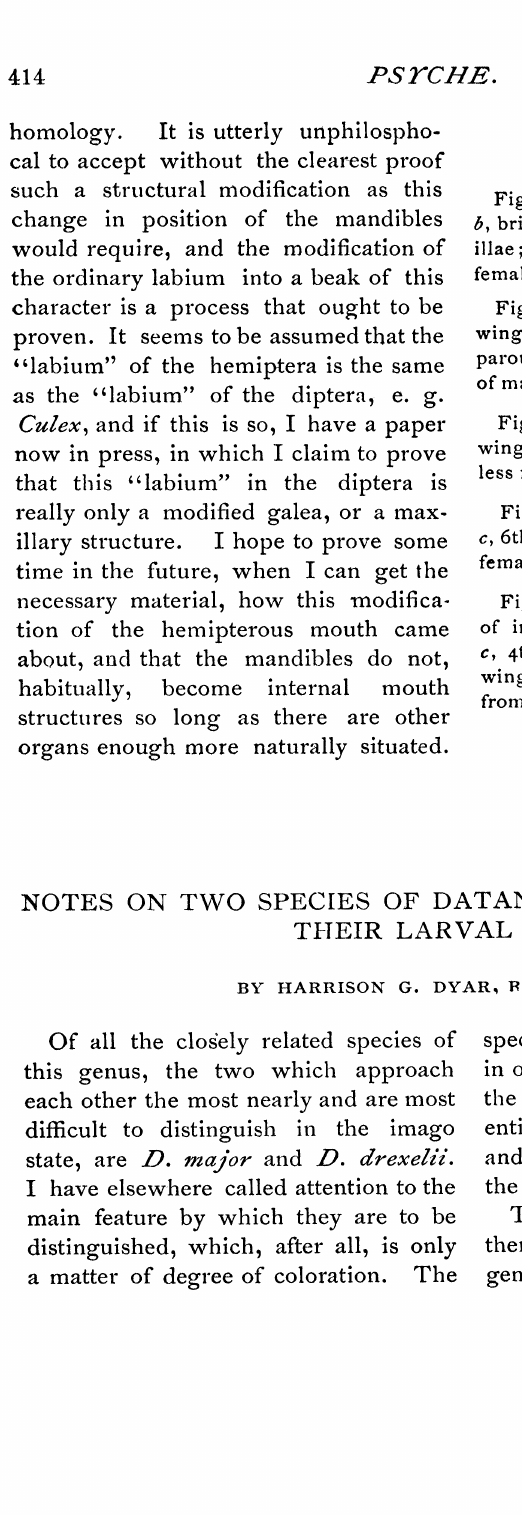
Fig. 2. A2bhis brassicae,